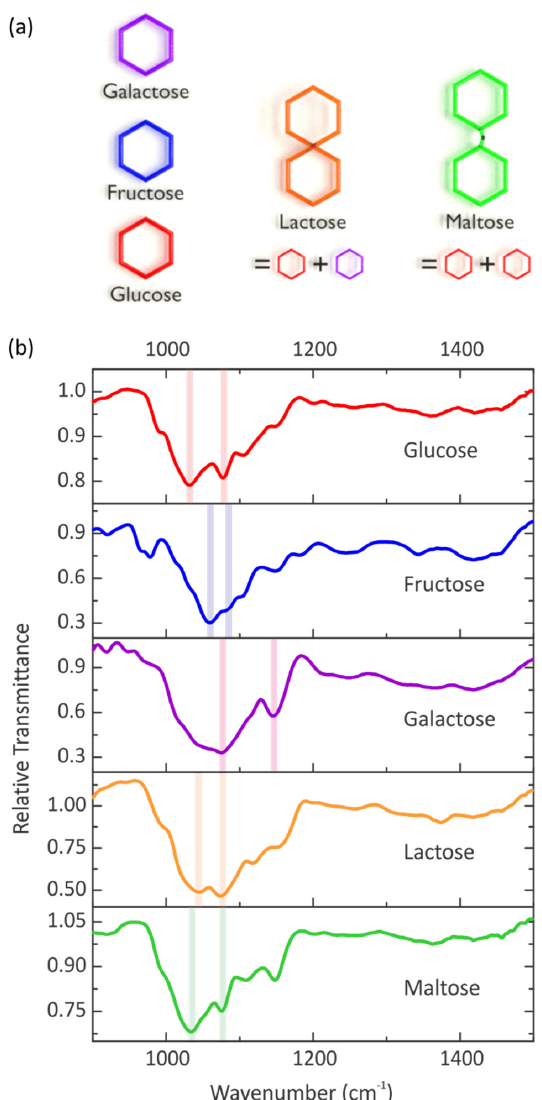
Figure 1. ( a ) Artistic sketch of the structures of the three monosaccharides glucose, fructose, and galactose, as well as the two disaccharides lactose and maltose. The lactose molecule is composed of a glucose and a galactose sub-unit, while maltose consists of two glucose sub-units. The disaccharides are thus expected to have similar vibrational spectra when compared to the individual sub-units, rendering their discrimination challenging. ( b ) Relative transmittance spectra of five sugar layers. The layers are spin coated from an aqueous sugar solution with a concentration of 100 g/L on a silicon substrate. The spectra are referenced to a bare silicon substrate to show the individual vibrational modes of glucose, fructose, galactose, lactose, and maltose, where the lines emphasize the most prominent vibrational